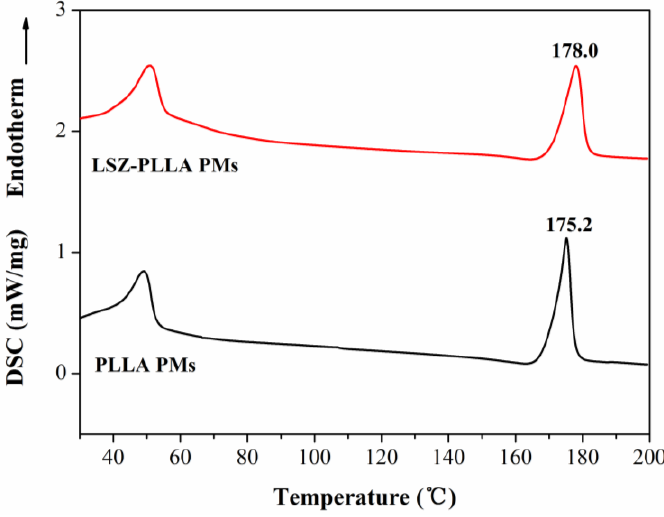
Figure 6. Differential scanning calorimetry (DSC) curves of blank PLLA PMs and LSZ-PLLA PMs.